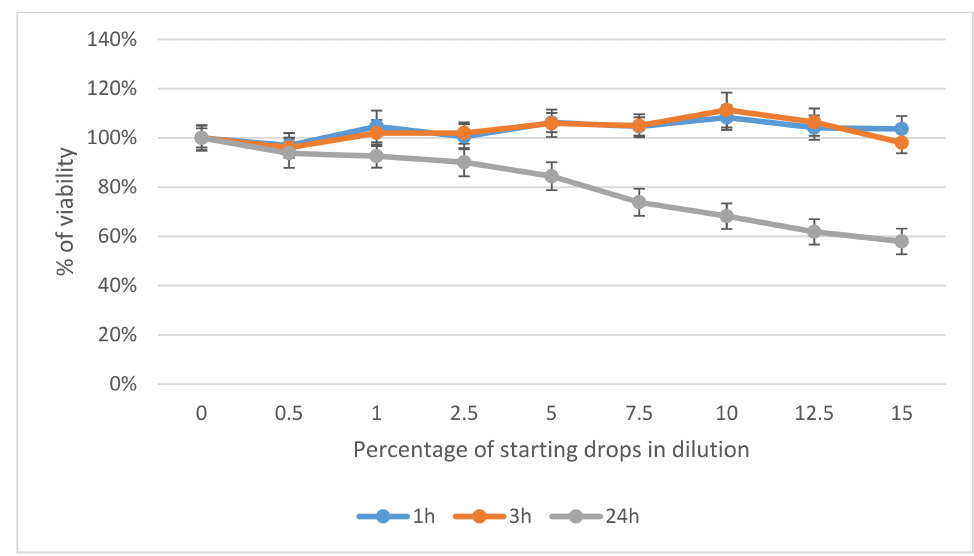
Figure 2. Effect of Ozodrop ® preparation on the viability of human conjunctival epithelium (HC0597) in vitro after 1, 3, and 24 h of incubation. Cell viability was determined by means of neutral red cytotoxicity (NR) assay.